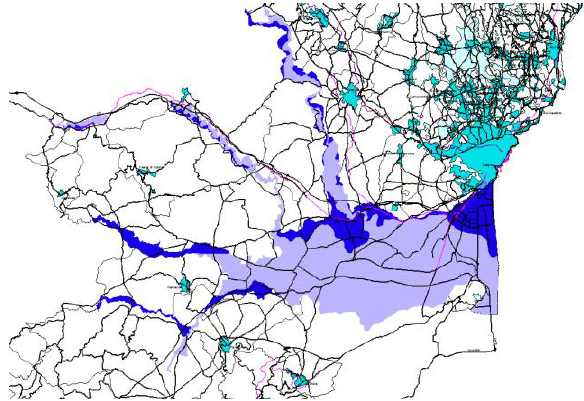
Figure 2. Simulated scenario of flooding in the province of Catania (D'Andrea et al.,